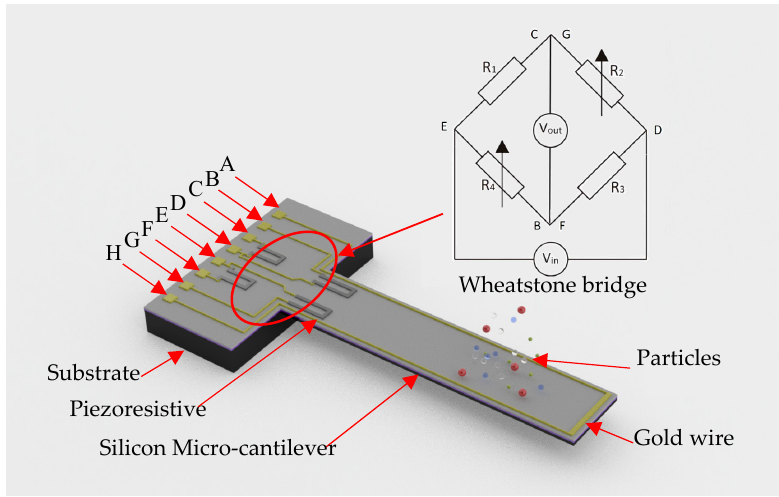
Figure 1. 3D Visualization of the MCL-based mass sensor. A: actuate voltage (+); B and F: output voltage (+); C and G: output voltage ( − ); E: input voltage (+); D: input voltage ( − ).